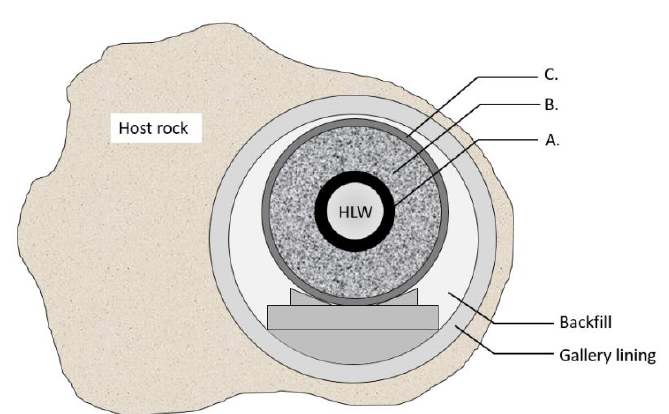
Figure 1. Cross- section of the “supercontainer” reference concep t with its main components: (A) carbon steel liner (overpack), (B) concrete reinforcement (buffer) and (C) envelope liner.